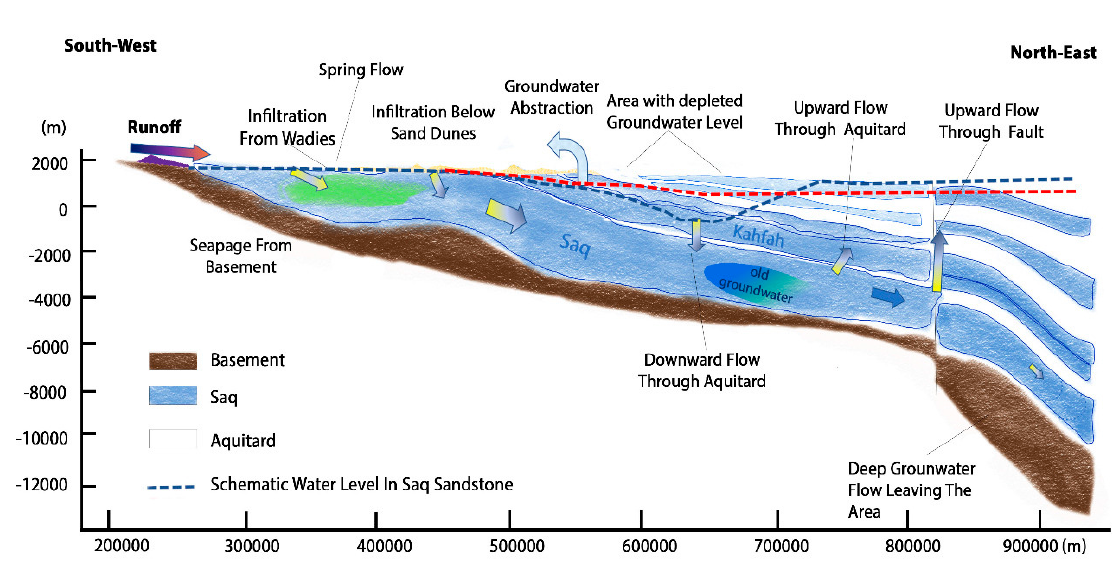
Figure 4. Cross-section of Saq Aquifer (After Al Salamah et al. [4]).